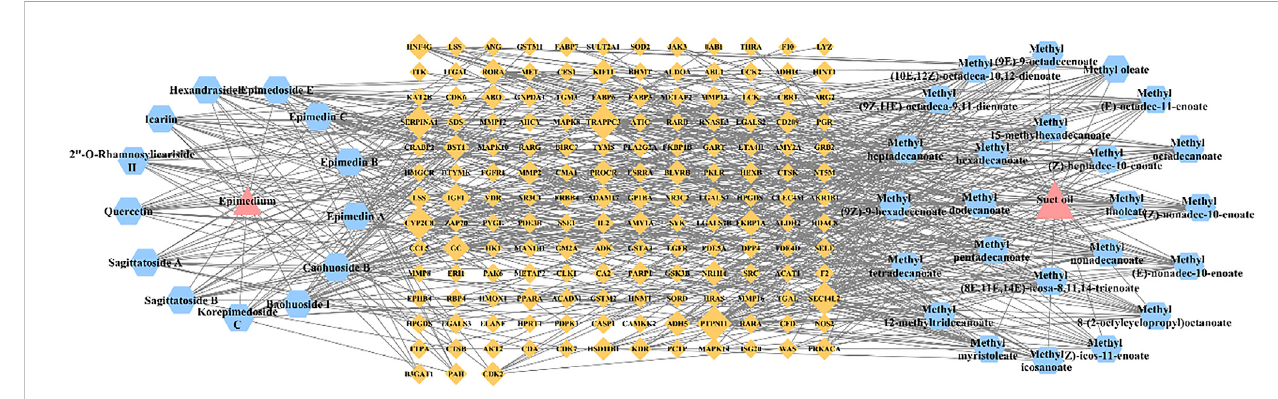
FIGURE 8 Pharmacology network of the “ drug-active compounds-target ” regulated by Epimedium fried with suet oil pink triangles indicate drugs, blue hexagons indicate active compounds, yellow diamonds indicate target genes.